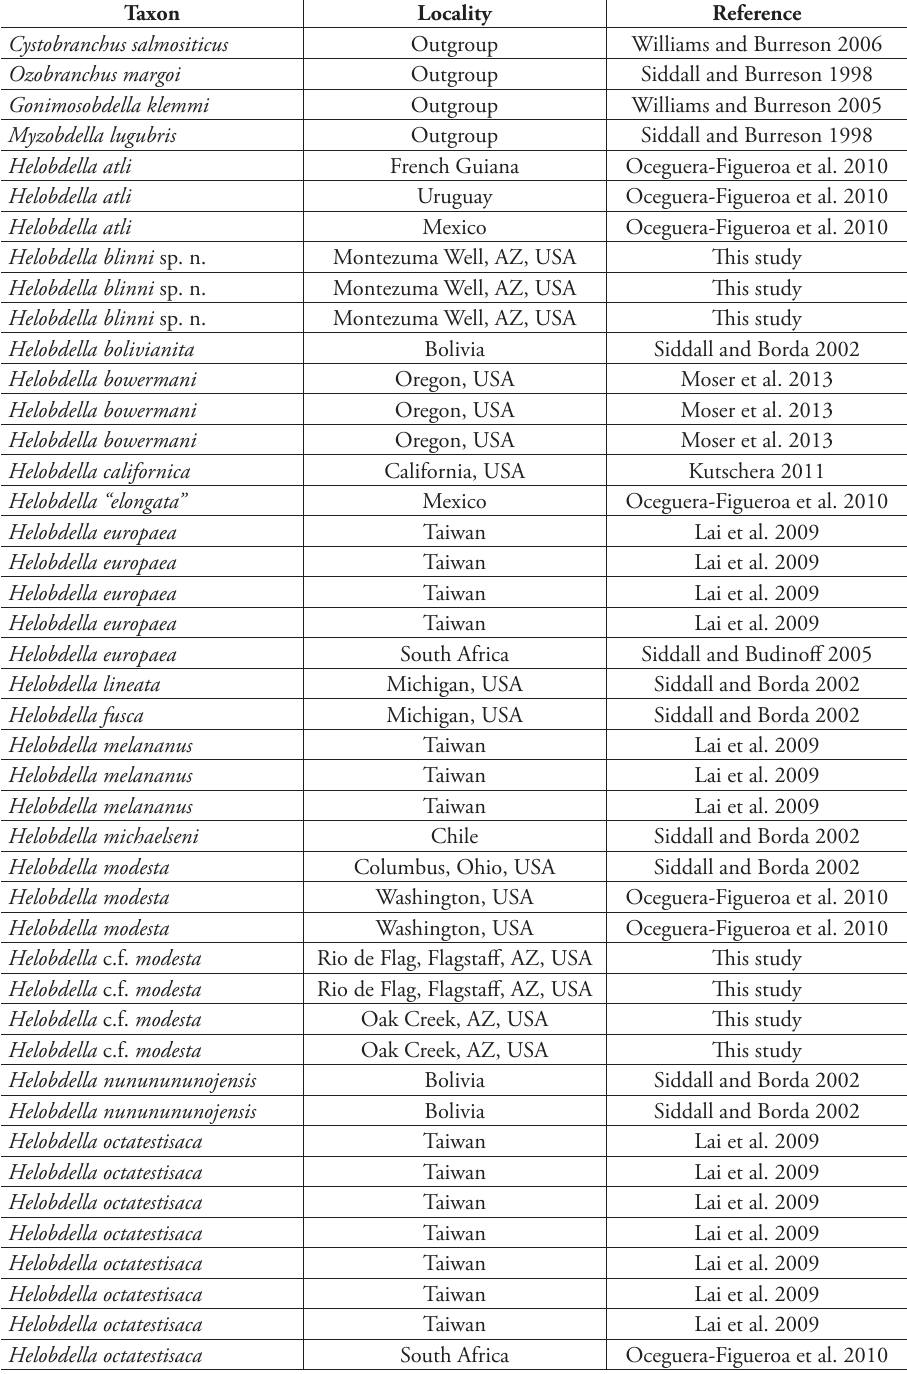
Table 1. Helobdella and outgroup taxa used for our molecular